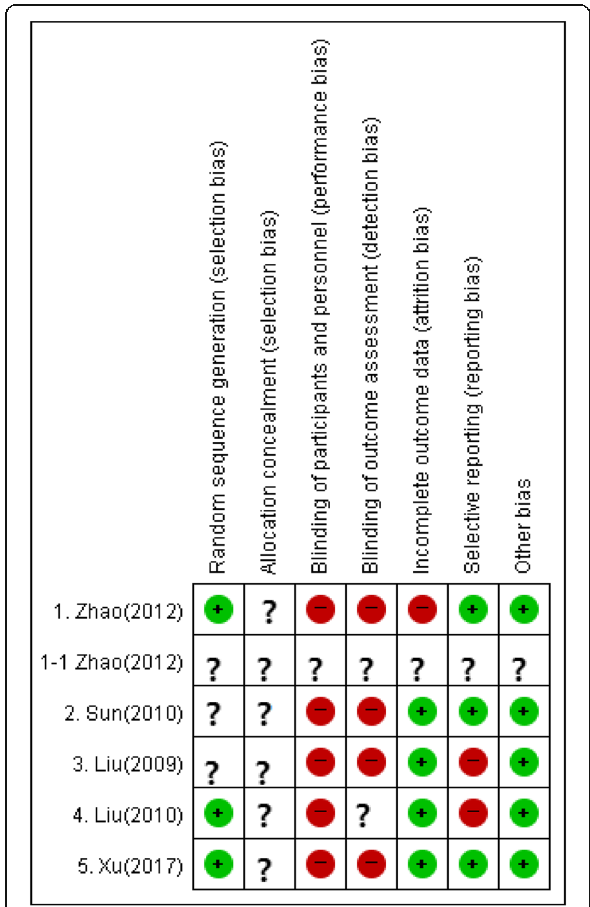
Fig. 2 Risk of bias of studies included in the meta-analysis on effect of electroacupuncture to MCI patients